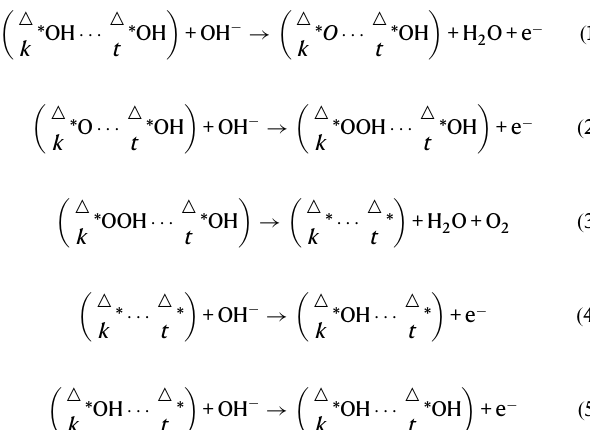
The possible OER paths over the Co tetrahedra are illustrated in Fig.S27.Figure4apresentsthefreeenergydiagramsforthemostlikely